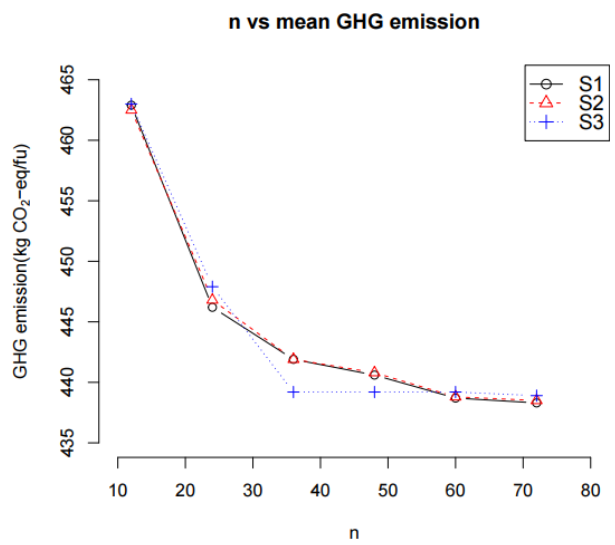
Figure 2. The effect of the size of the dataset ( n ) on the mean greenhouse gas (GHG) emission.